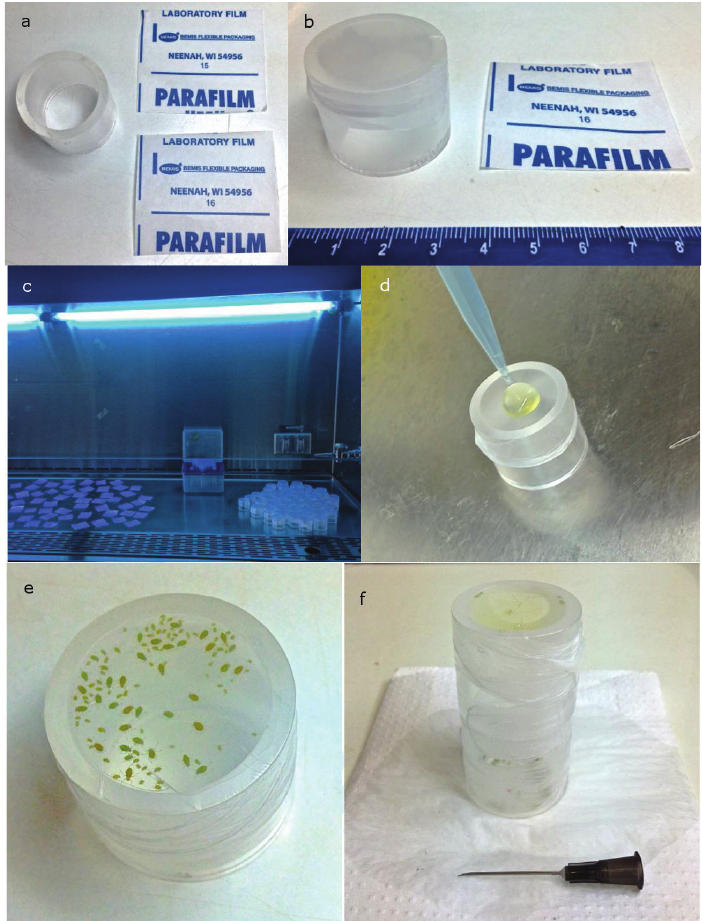
Figure 1 - Artificial tritrophic system for rearing aphids and